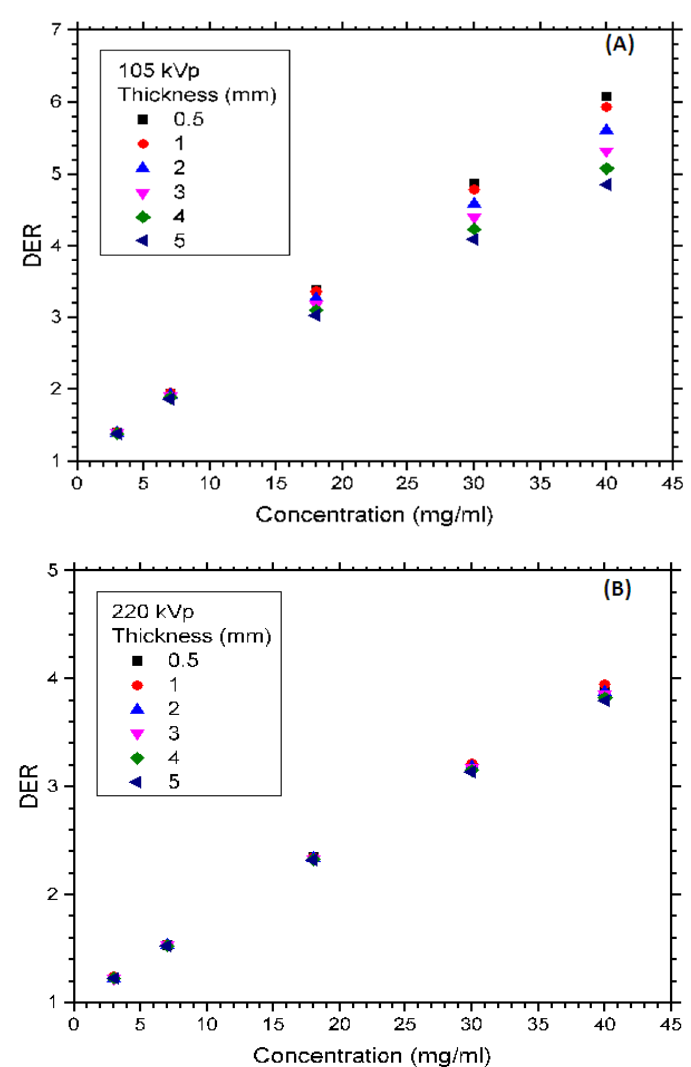
Figure 4. Relationship between the dose enhancement ratio and Au NP concentration with variation of the skin target thickness using the 105 ( A ) and 220 kVp ( B ) photon beams